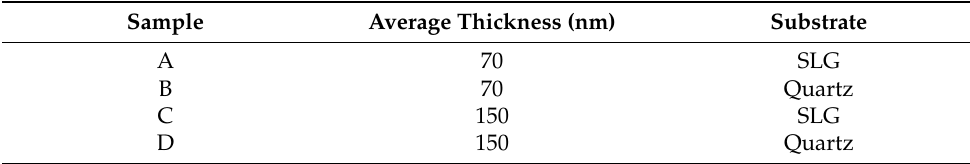
Table 1. Name, thickness and substrate type of investigated